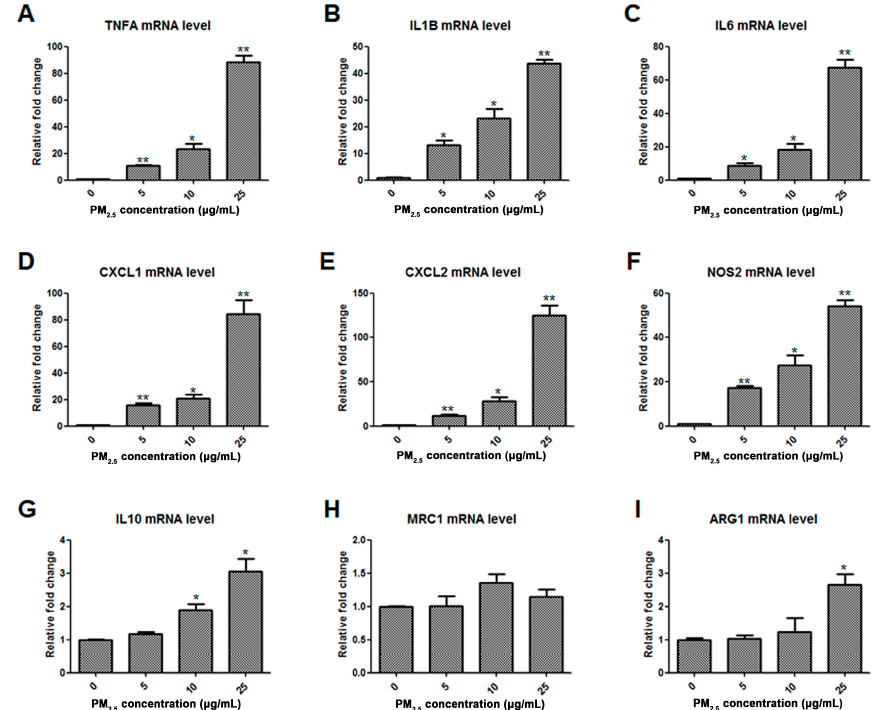
Figure 1. Effects of PM 2.5 on macrophage polarization. NR8383 cells were treated with 0, 5, 10, and 25 μ g/mL PM 2.5 for 6 h, and the mRNA levels of TNFA ( A ), IL1B ( B ), IL6 ( C ), CXCL1 ( D ), CXCL2 ( E ), NOS ( F ), IL10 ( G ), MRC1 ( H ), and ARG1 ( I ) were measured by real-time RT-PCR. Data are presented as mean ± SD, and represent three independent experiments. * p < 0.05 and ** p < 0.01, compared with the control group treated without PM 2.5